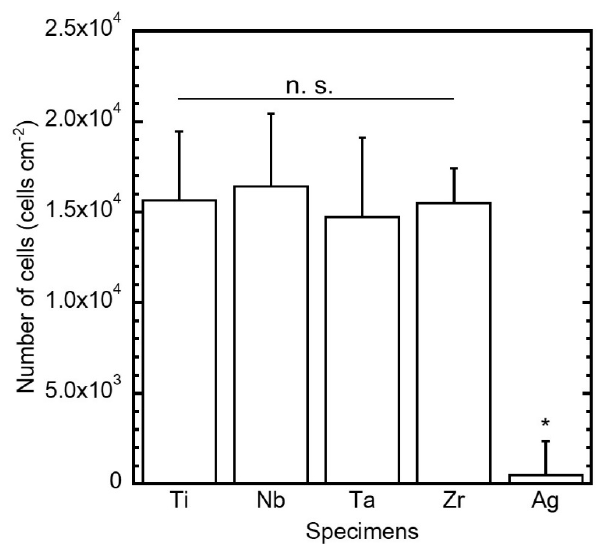
Figure 4. The number of living cells on each specimen 24 h after seeding. Data are shown as the mean ± SD. *: Significant difference; n.s.: No significant difference (ANOVA + Student-newman-keuls (SNK) ( p < 0.05, N = 5)).